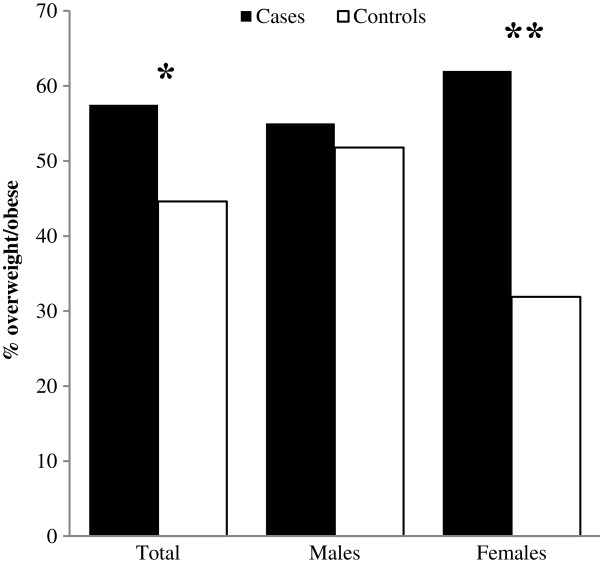
Prevalence of overweight/obesity in cases and controls, considered as the whole sample or stratified by gender. The chi-squared test was used to compare the proportions of overweight/obese children between groups. *p = 0.01; **p < 0.001.